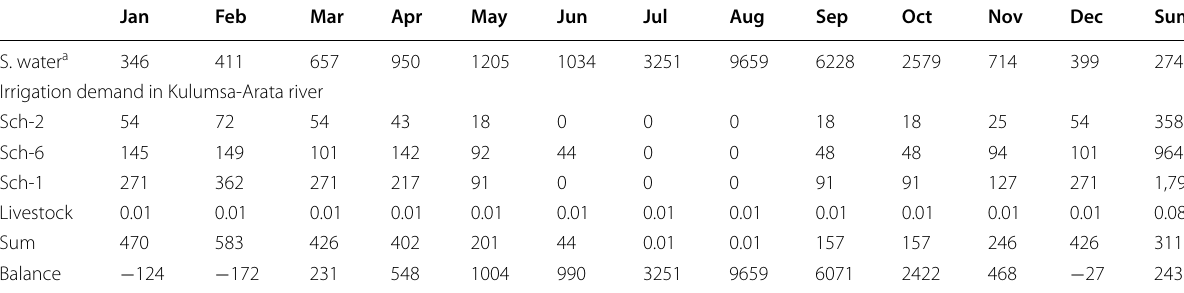
Table 8 Monthly water balance of Kulumsa (‘000 m 3